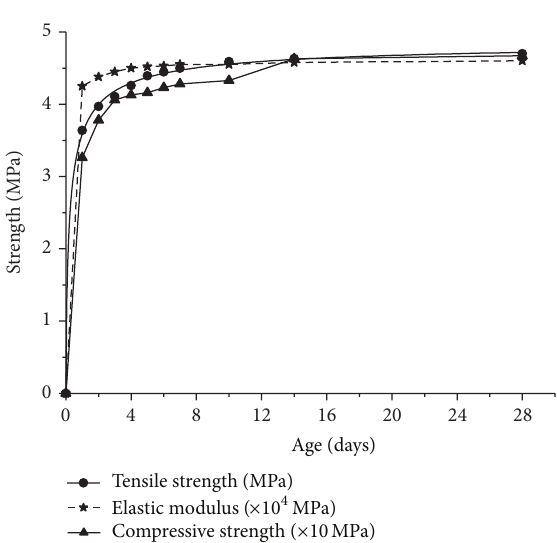
Figure 3: Compressive and splitting tensile strengths and elastic modulus of